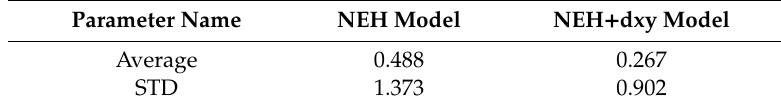
Table 3. Residual Error of Two Estimation Model (Unit: